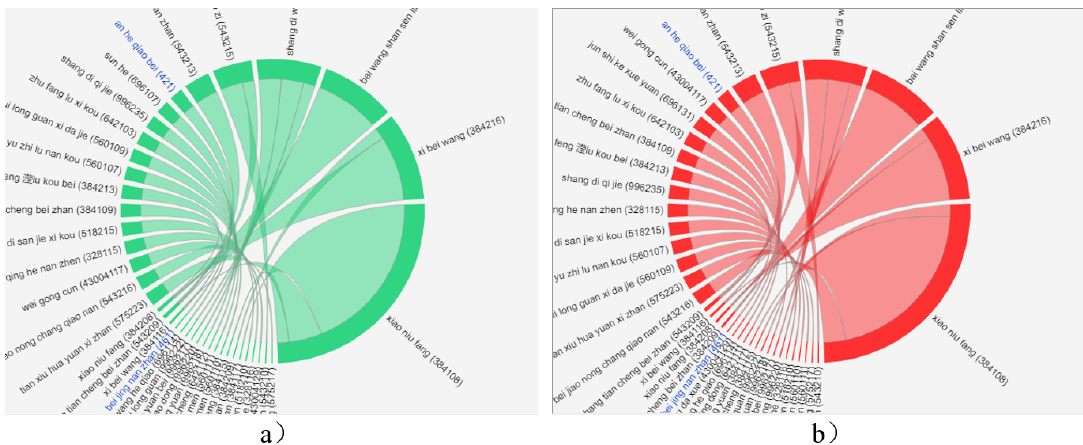
Figure 14. Normal passenger analysis—chord view ( a ) Card number 23185887, ( b ) Card number